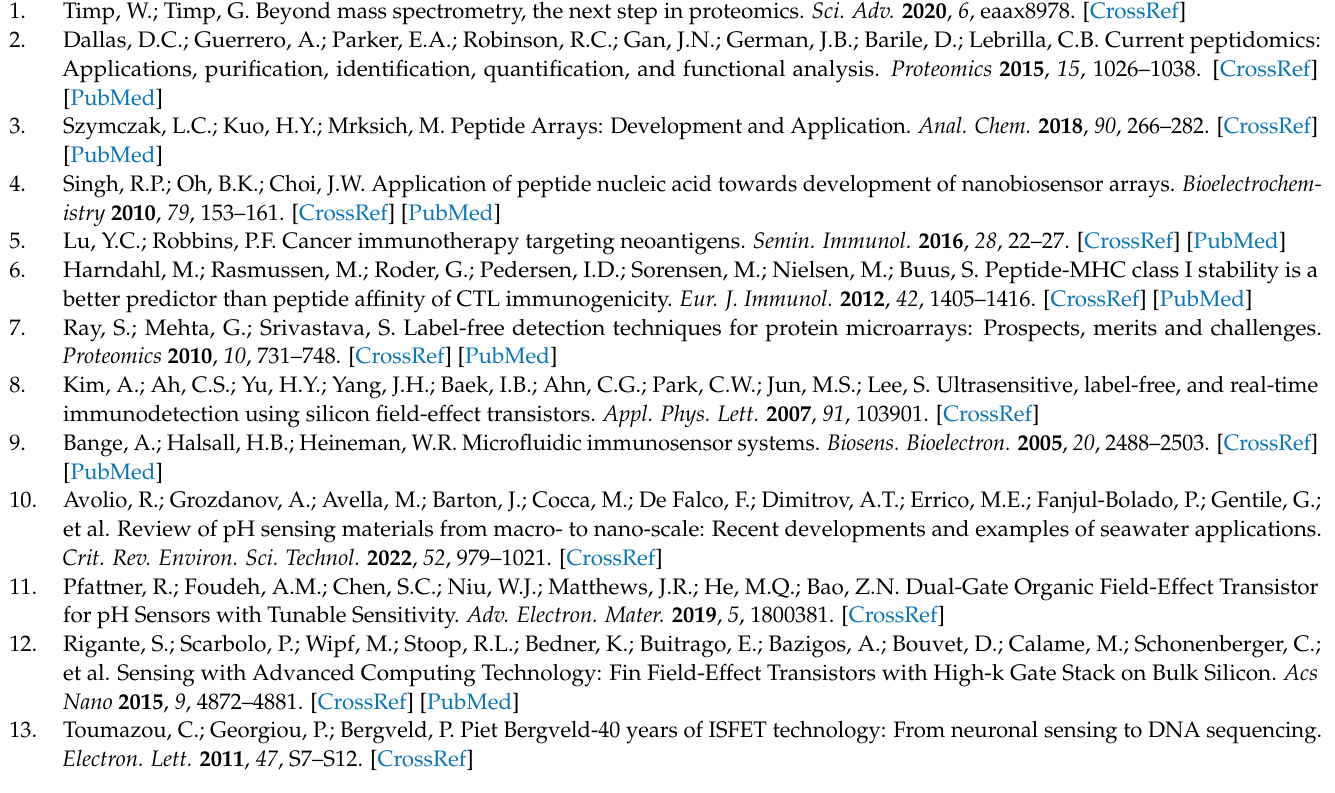
Figure S10: XPS spectra for Silicon and primary amine presence arrangement after APTES grafting on bare SiO 2 sensor; Figure S11: Representative SPR response showing real time binding events of peptide and Ab (1 µ g/mL); Figure S12: Ids vs. time for a pH of 7.74 PBS buffer; Table S1: Elemental and chemical composition recorded with XPS on bare SiO 2 , and APTES grafted SiO 2